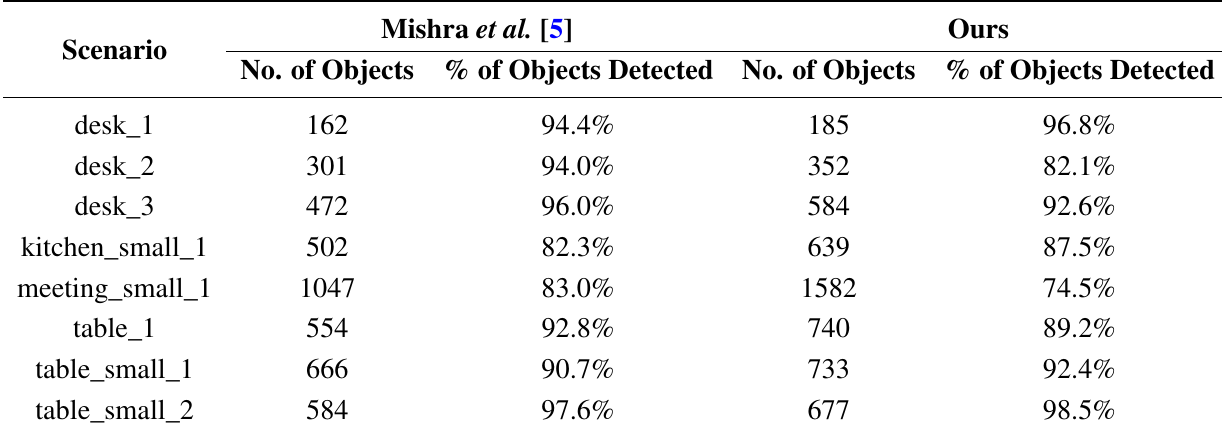
Table 4. Comparison of the detection rate on the RGB-D scene dataset.